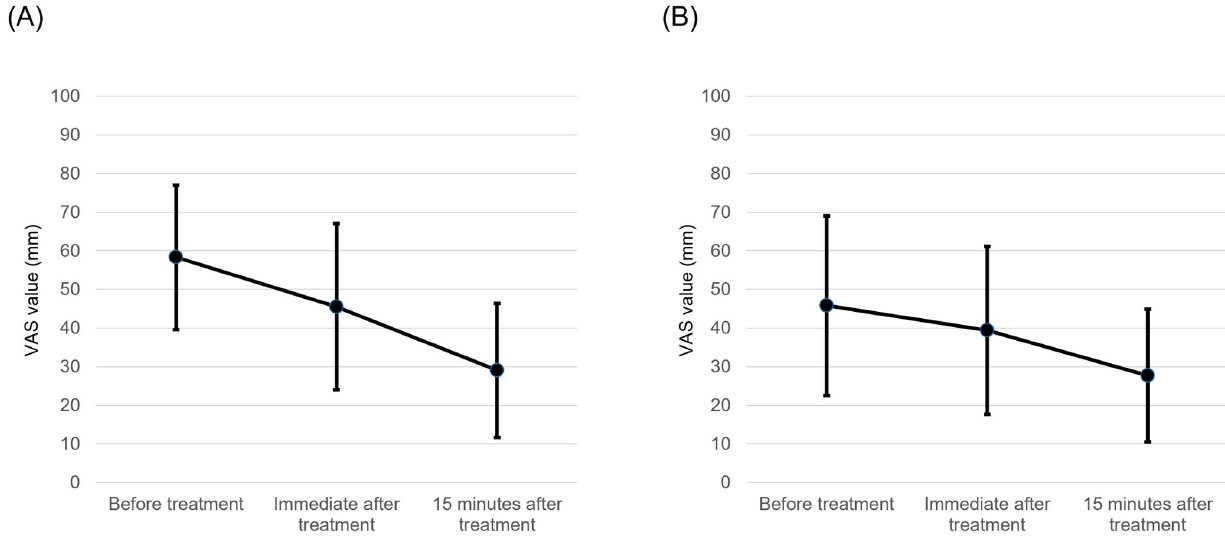
Fig 2. The effect of LED light irradiation on the VAS for chronic neck with shoulder muscle stiffness and pain for each subject. Variations in VAS scores of the (A) neck with shoulder muscle stiffness and (B) pain before, immediately after, and 15 minutes after treatment.